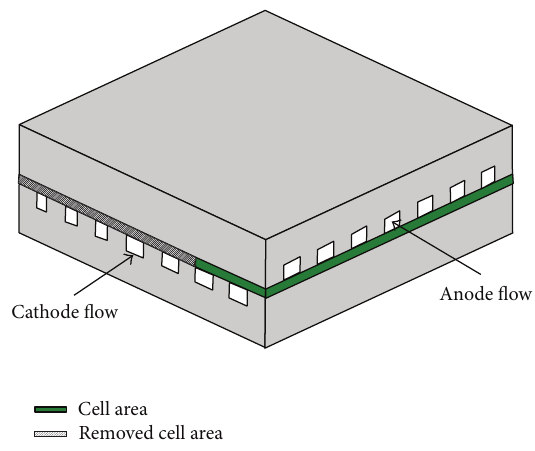
Figure 1: Illustration of the orientation of the quarter cell with respect to flow directions.